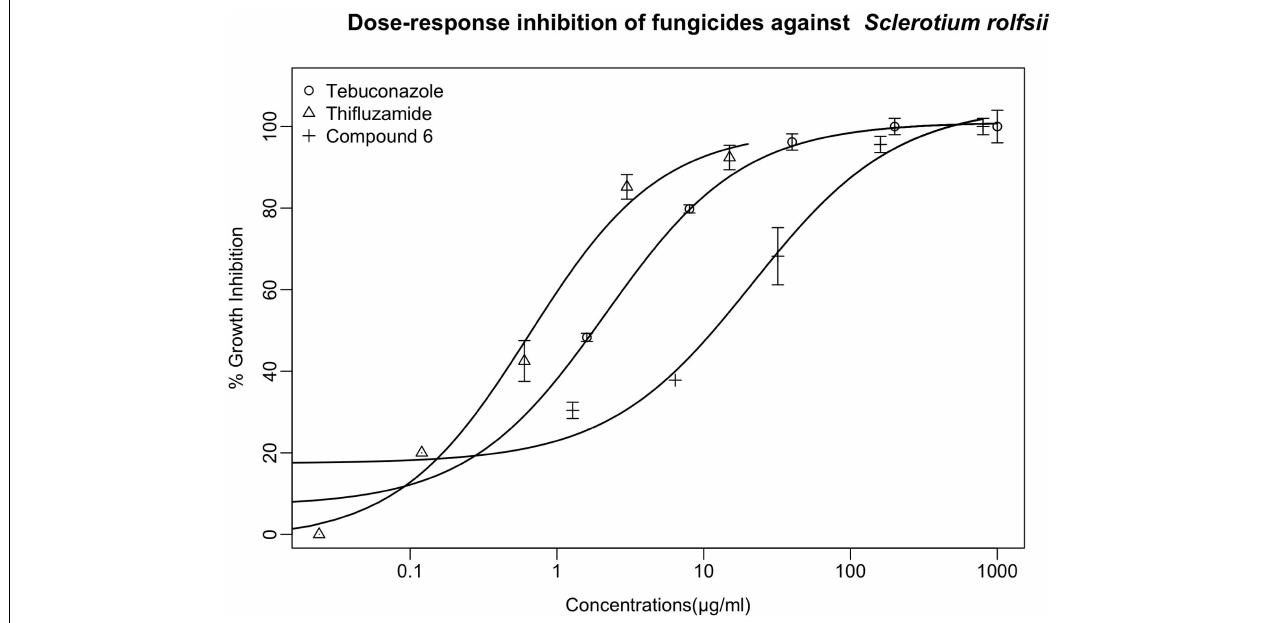
FIGURE 3 | The dose-response inhibitory effects of compounds 6 and two controls (tebuconazole and thifluzamide) against S. rolfsii were measured with PDA assay. Points indicate means, and bars indicate SD ( n = 4). TABLE 2 | Effect of compound 6 and two controls on southern stem rot incidence and peanut yield in field study.